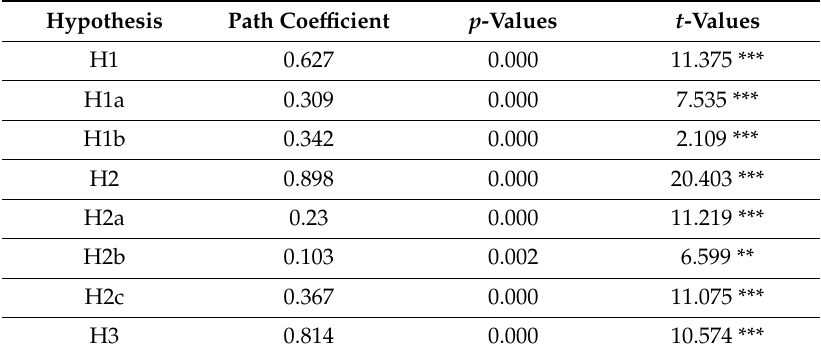
Table 6. Hypotheses test